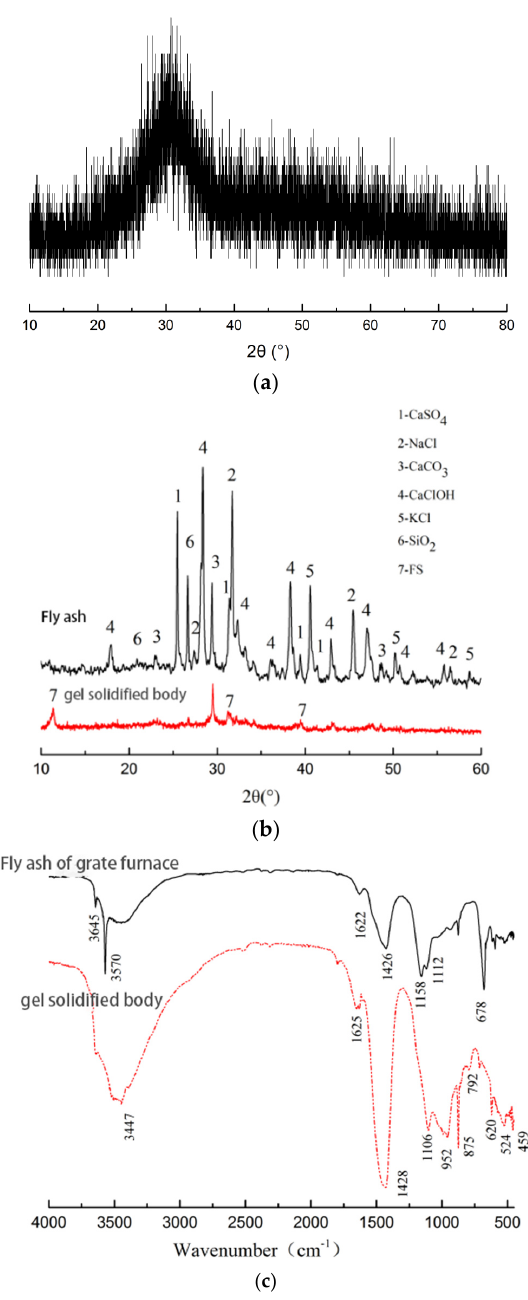
Figure 4. Solidification effect analysis of mineral slag and fly ash and gel solidified body. ( a ) The XRD pattern of mineral slag. ( b ) XRD patterns of fly ash and solidified body from grate furnace. ( c ) Infrared spectra of fly ash and solidified body.